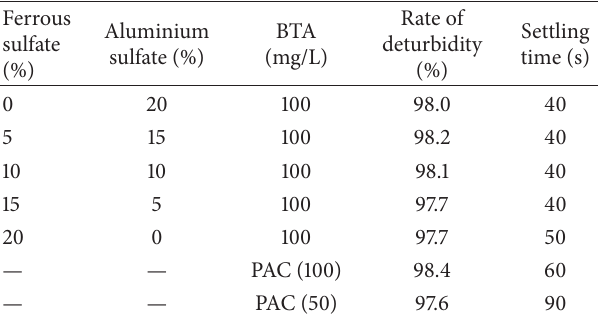
Table 4: The influence of additives on coagulation behaviors of BTA with 20% PAC (200NTU diatomite suspension).